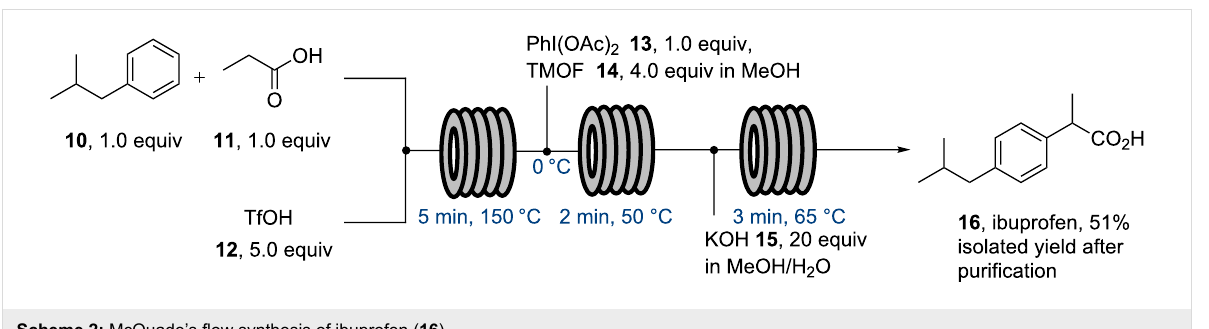
Scheme 2: McQuade’s flow synthesis of ibuprofen ( 16